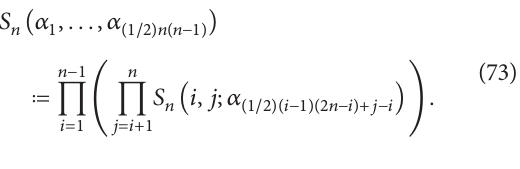
𝐾(1,0.5,1) , P 0.3